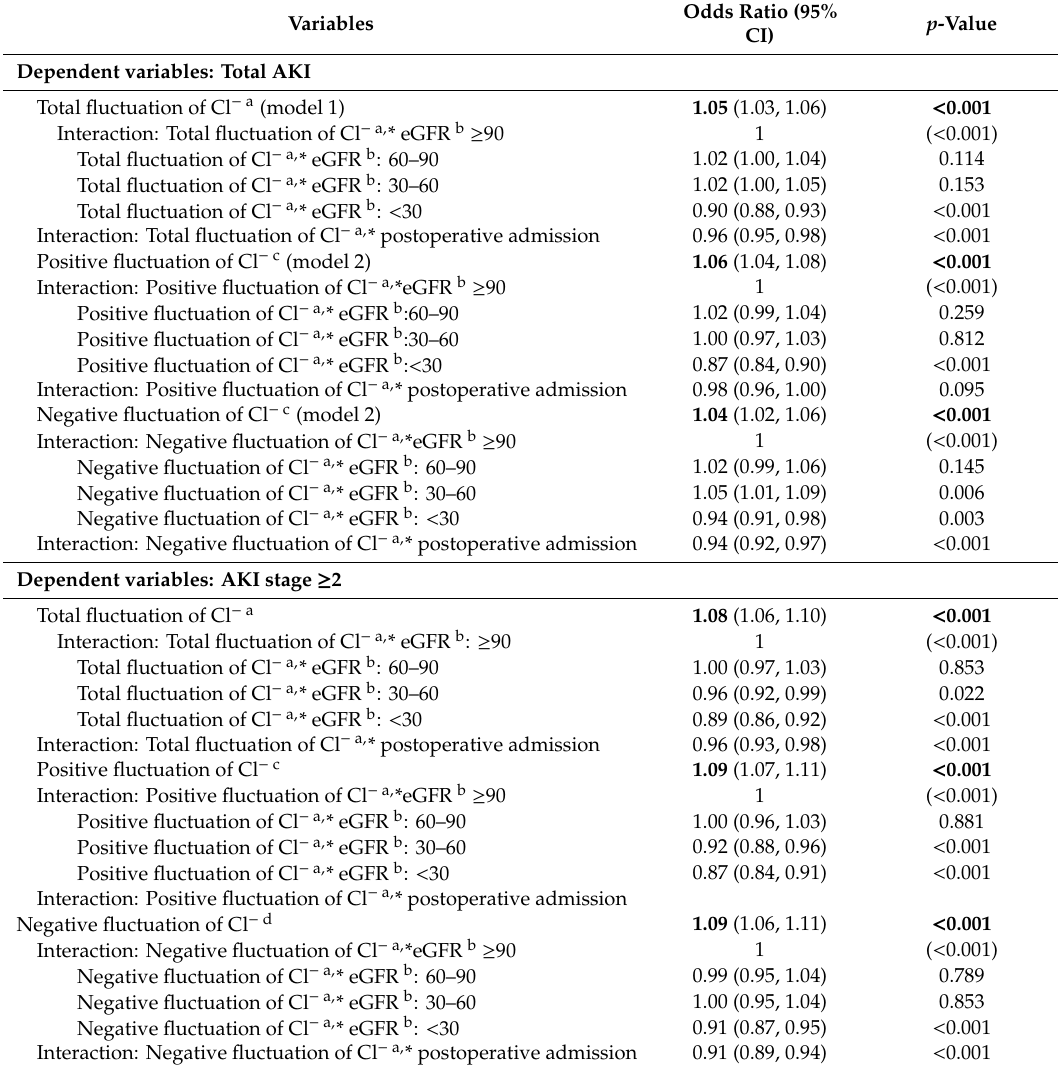
Table 2. Multivariable logistic regression analysis for total AKI and AKI stage ≥ 2 after ICU admission according to fluctuations of serum chloride (mmol L − 1